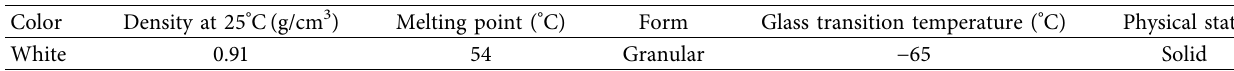
Table 5: The properties of Vestenamer polymer used.